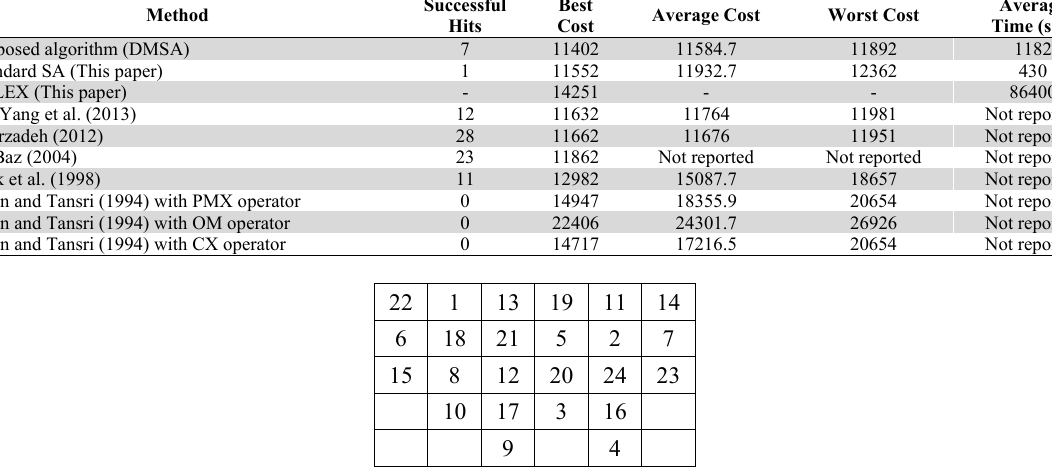
Fig. 8. The best solution obtained by the proposed algorithm for problem 1